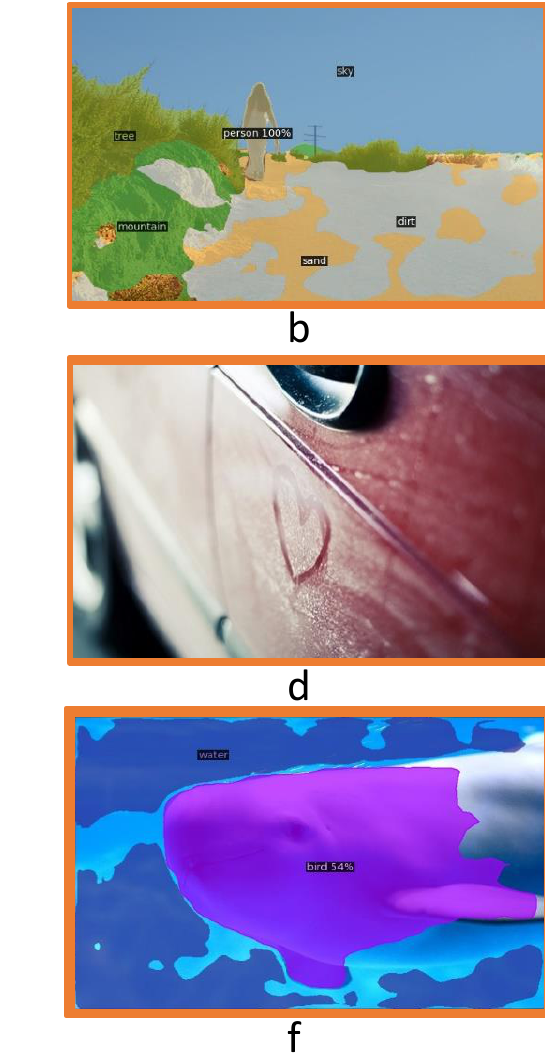
Figure 6. Example of panoptic segmentation. Given the raw images ( a , c , e ), panoptic segmentation generates the accurate result ( b ), category missing result ( d ) and misclassification result ( f